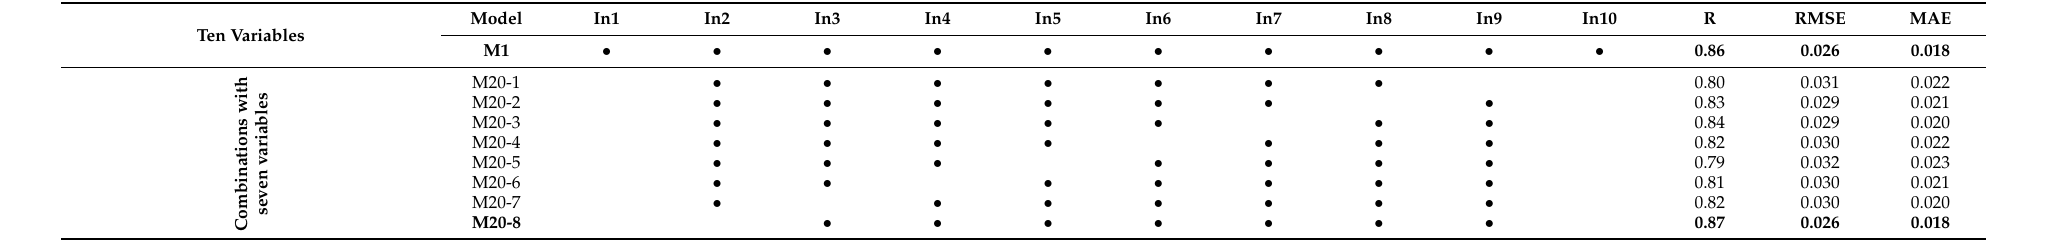
Table 4. Models in the systematic controllability variable reduction approach for seven and six bone curvature region variables with their performance in predicting medial condyle cartilage volume loss at one